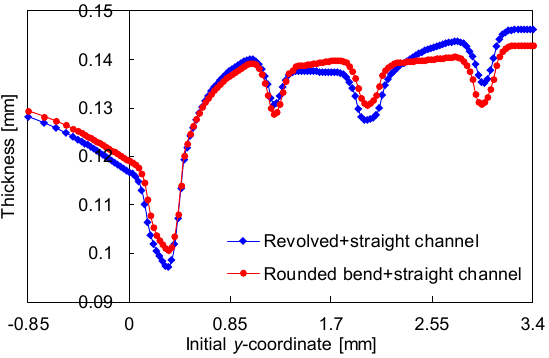
Figure 21. Thickness distribution in a single channel at x = 0, for the two different models. The parameters are w 1 = s = 1.2 mm, r = R = 0.3 mm, and h = 0.7 mm.